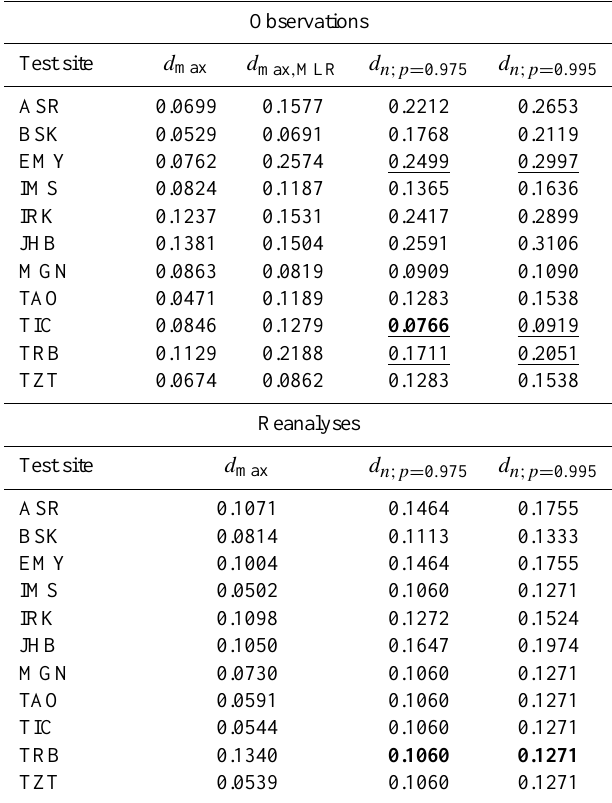
Kolmogorov-Smirnov goodness-of-fit test (see Ap- pendix A2). Rejections are marked in bold (Weibull distribu- tion paramters estimated from observations) and/or are underlined (Weibull distribution parameters estimated by